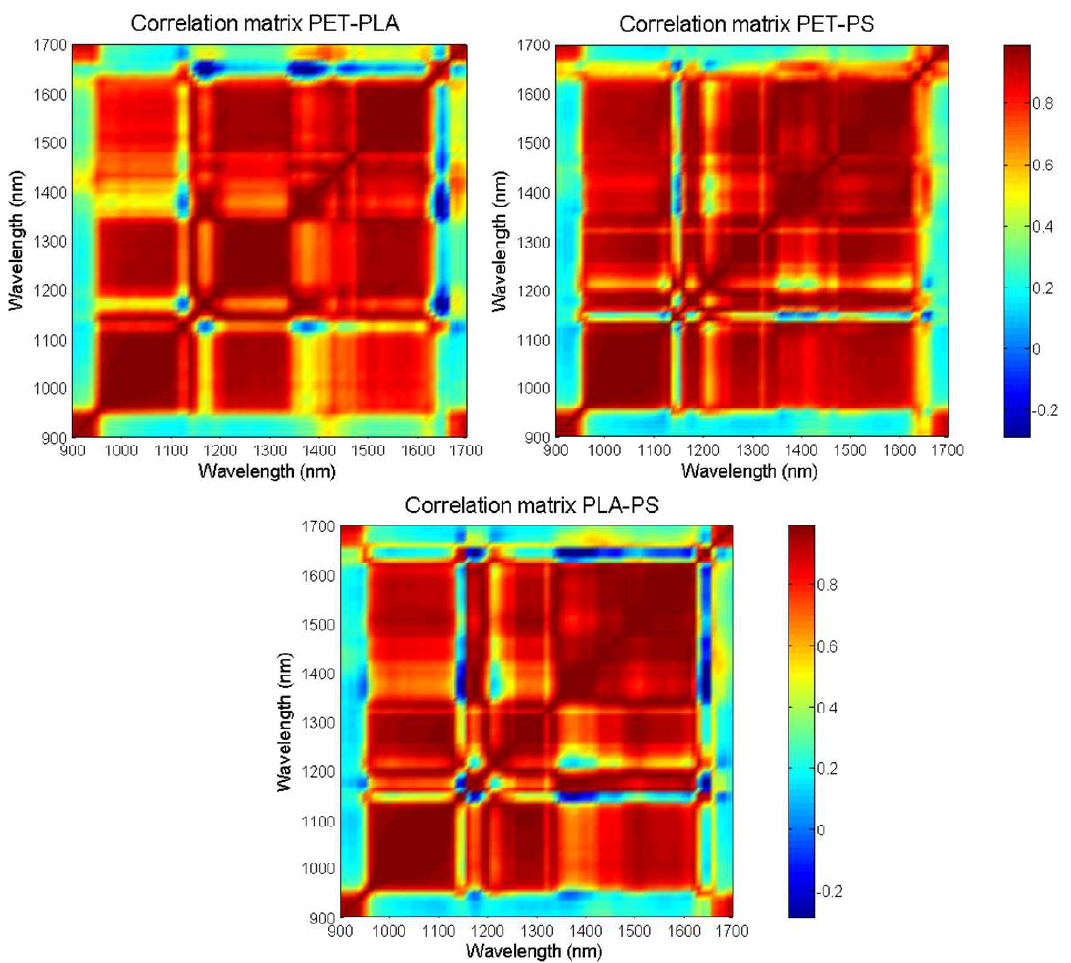
Figure 8. Correlation matrix of PET-PLA, PET-PS, PLA-PS; the spectral signatures of primary raw material samples are employed for the computation of the correlation matrices.